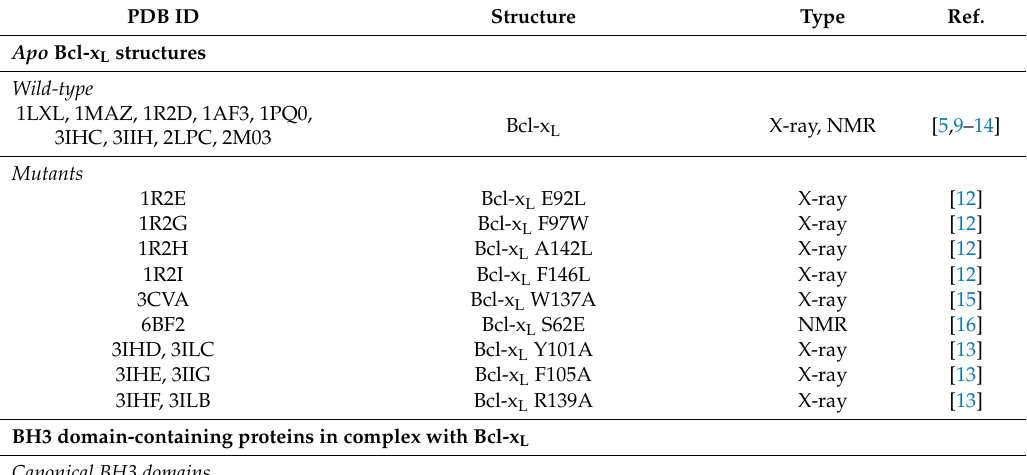
Table 1. Structures of Bcl-x L in the Protein Data